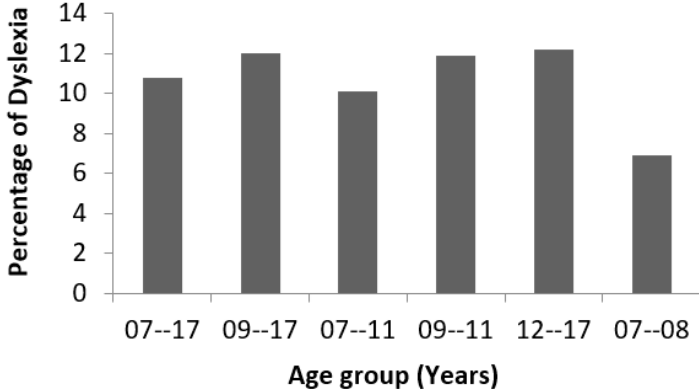
Figure 2. Age wise percentage of dyslexia.